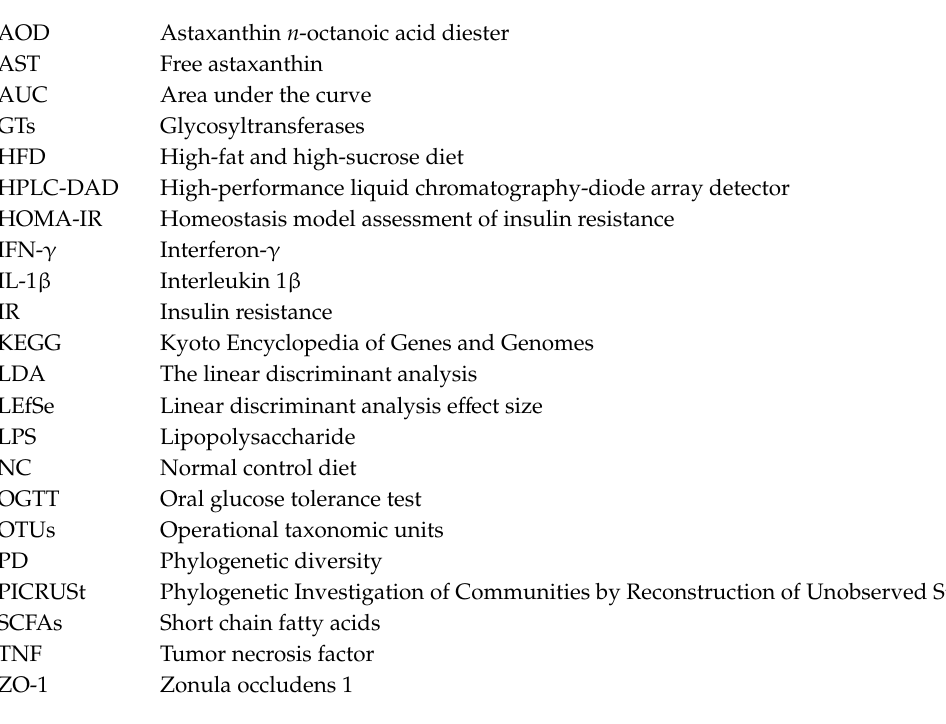
s1. Figure S1: E ff ect of astaxanthin on body weight and food intake of mice. Table S1: The OTUs per sample identified in this stud. Table S2: Composition of rodent diets. Table S3: Primer sequences for RT-PCR